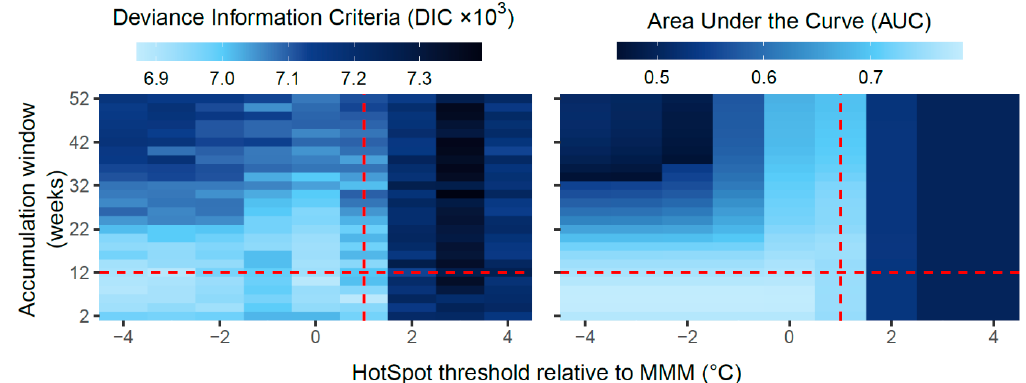
Figure 3. Model comparison heatmaps showing the deviance information criterion (DIC) and area under the curve (AUC) for 234 generalised linear models (GLMs) that each predict coral bleaching based on a different DHW test metric. Raster cells represent individual GLMs plotted by HotSpot threshold and accumulation window. The threshold and window used for DHW op are shown by red dashed lines (MMM + 1 °C, and 12-weeks). Results for the DHW op GLM are not shown on the heatmaps (DIC = 6967, AUC = 0.758).